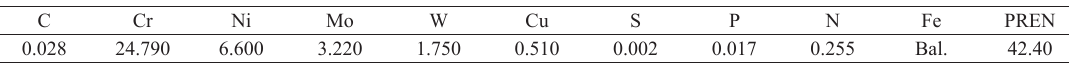
Figure 1. Specimens orientation as respect to the seamless Table 1. Chemical composition (wt%) and PREN of the UNS S39274 SDSS studied.